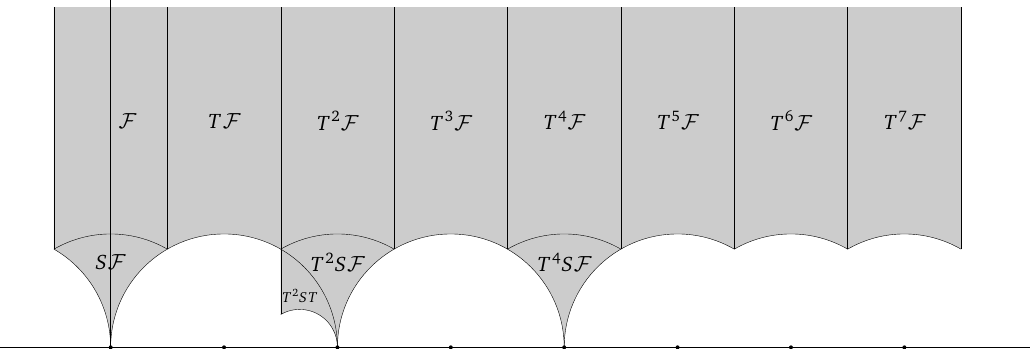
Figure 14: A fundamental domain for Γ 0 ( 8 ) on the upper half-plane. The four cusps at τ = 0,2,4, i ∞ have widths 1, 2, 1 and 8, respectively. The modular curve (cid:72) / Γ 0 ( 8 ) is isomorphic to the Coulomb branch of the massless D